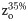
ET nucleotides cluster, and predict functional sites in the hammerhead ribozyme.(A) ET ranks mapped onto the structure of the hammerhead reveal clusters of ET nucleotides that overlap canonical functional sites (labeled nucleotides). (B) Clustering by ET nucleotides is statistically significant. (C) ET overlap z-score confirms that ET nucleotides inform both of the canonical functional sites. (To calculate site-specific zo35%, we remove other known sites from consideration).